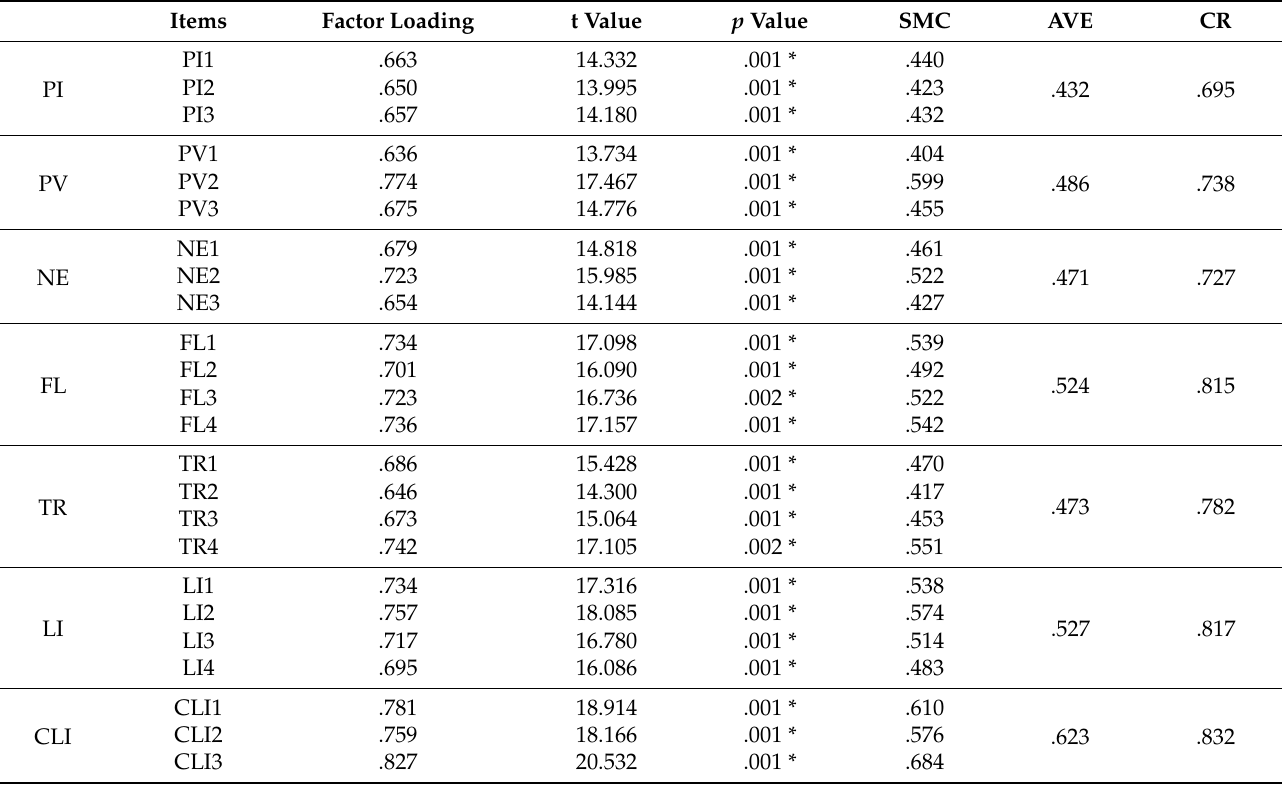
Table 7. Results of discriminant validity tests.